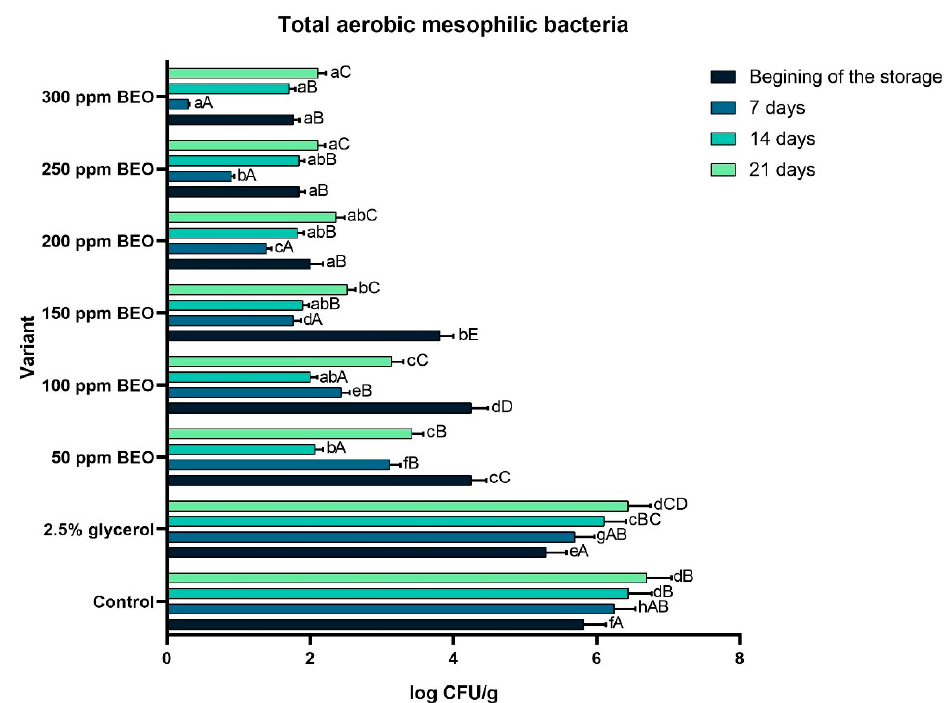
Figure 12. Effects of applied treatments on the total number of aerobic mesophilic bacteria during storage for 21 days at 8 ± 1 ◦ C. Bars for the same sampling time followed by different lowercase letters are significantly different based on the least significant difference (LSD) test ( p < 0.05). Bars for the same treatment during storage time followed by different uppercase letters are significantly different based on the least significant difference (LSD) test ( p < 0.05).